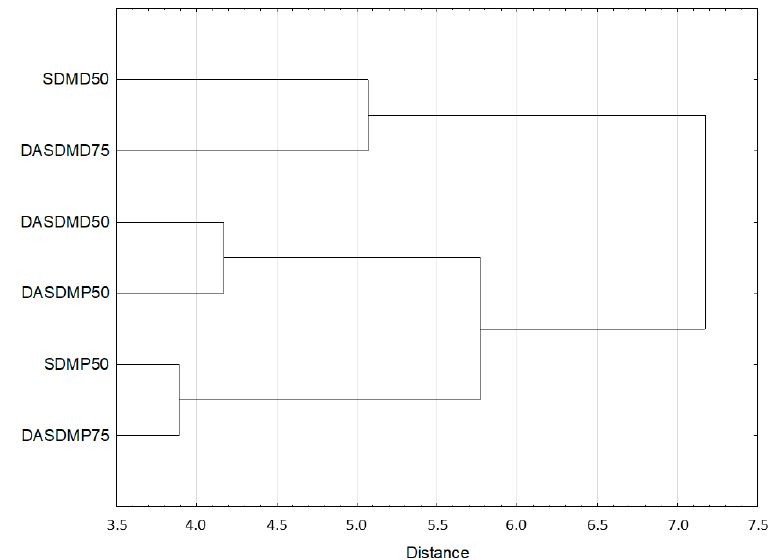
Figure 5. Dendrogram plot from HCA of obtained buckwheat honey powders.